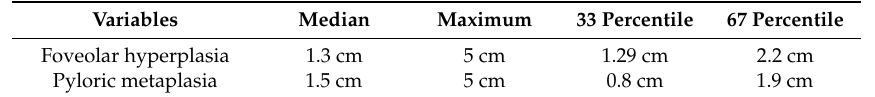
Table 2. Distribution range of reflux-induced mucosal changes from the anastomosis